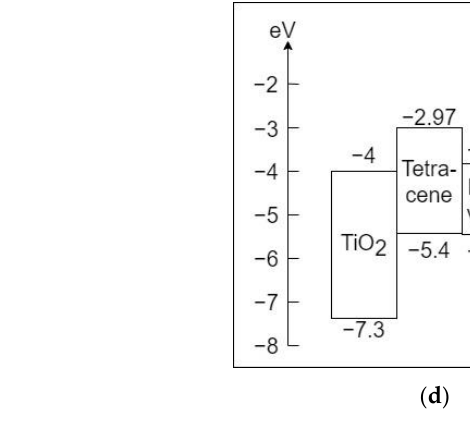
Figure 1. ( a ) The configuration for the control case. ( b ) The configuration for the experimental case. ( c ) Band diagram for the control case. ( d ) Band diagram for the experimental case.